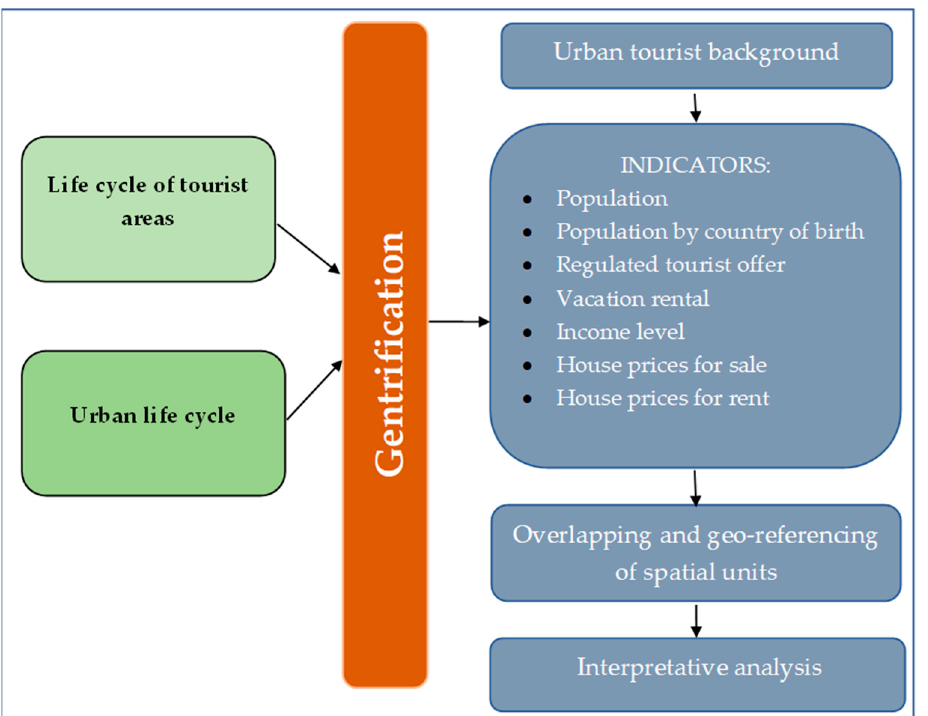
Figure 1. Methodological outline. Own elaboration.